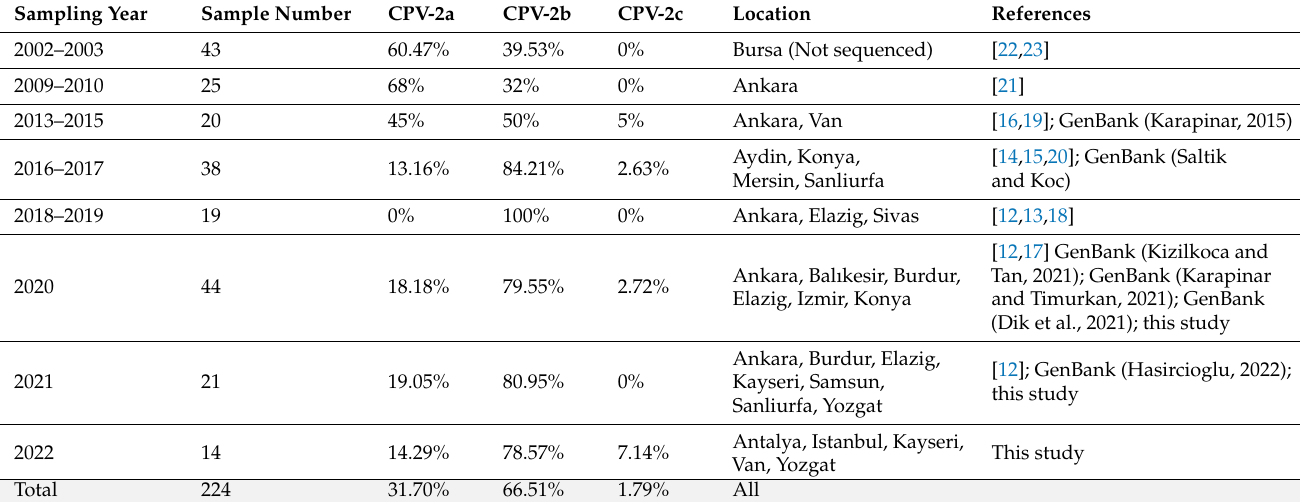
The gray-shaded amino acids are different from the reference. Table 4. Change of CPV strains in Turkey